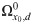
Details (of size 100 × 100) of the restored images contaminated by pure impulse noise using our method (OWMF) with different sizes of the detection window Ωx0,d0.The first image is restored with the size 3 × 3 of detection window, the second one with the size 5 × 5. The original image has been contaminated by an impulse noise with p = 20%.